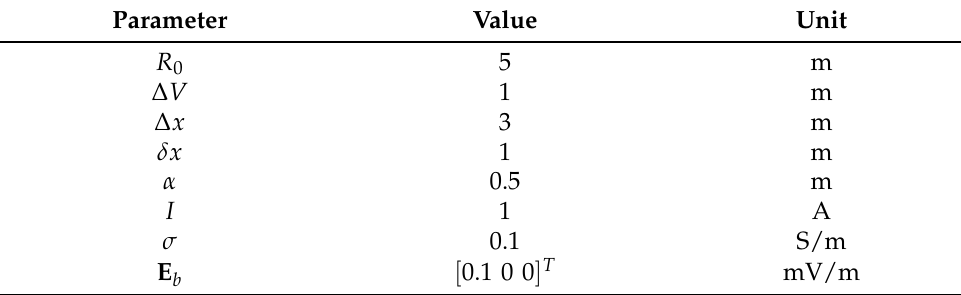
Table 2. Experimental parameters.